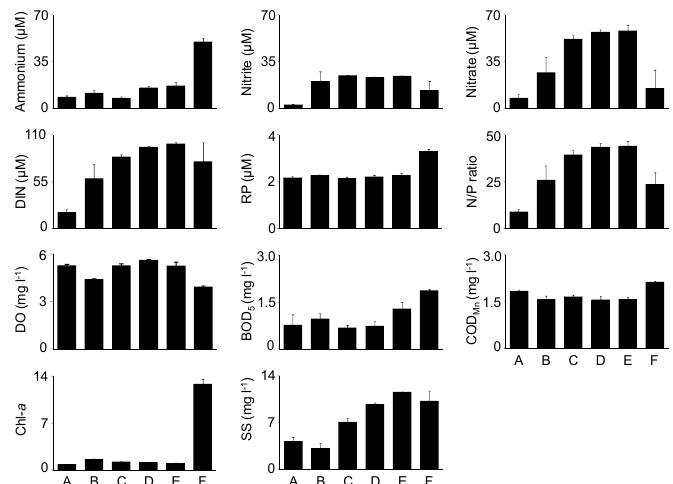
Figure 2. Mean value (n = 3; ± SE standard error) of near-bottom water variables at each site: ammonium, nitrate, nitrite, dissolved inorganic nitrogen (DIN = ammonium, nitrate, and nitrite), reactive phosphorous (RP), N / P, dissolved oxygen (DO), biological oxygen demand (BOD 5 ), chemical oxygen demand (COD Mn ), chlorophyll- a (Chl- a ), and suspended solids